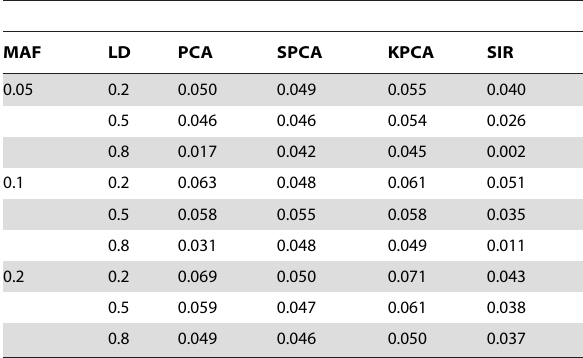
Table 6. Empirical type I error rates at the significance level of 0.05 based on 100 SNPs.